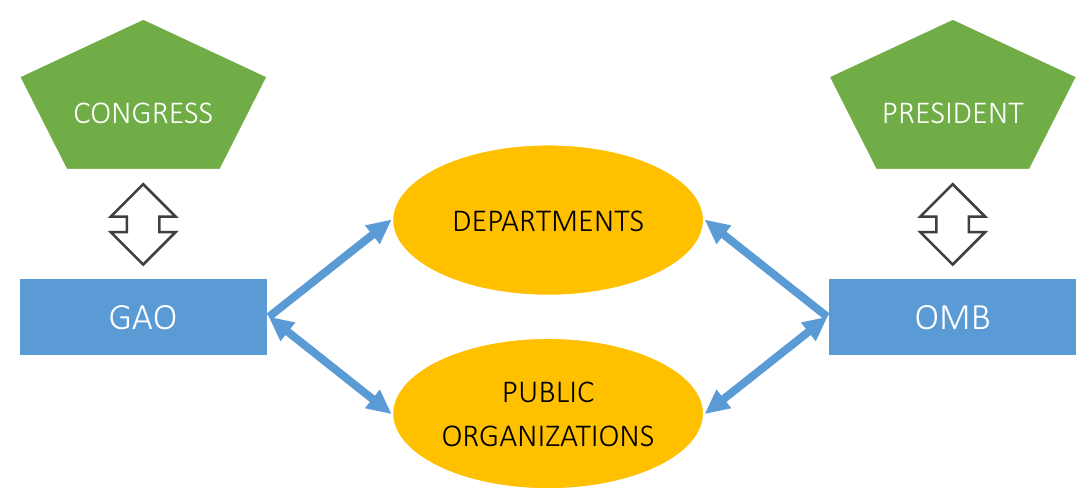
Figure 1. The system of the government audit in the